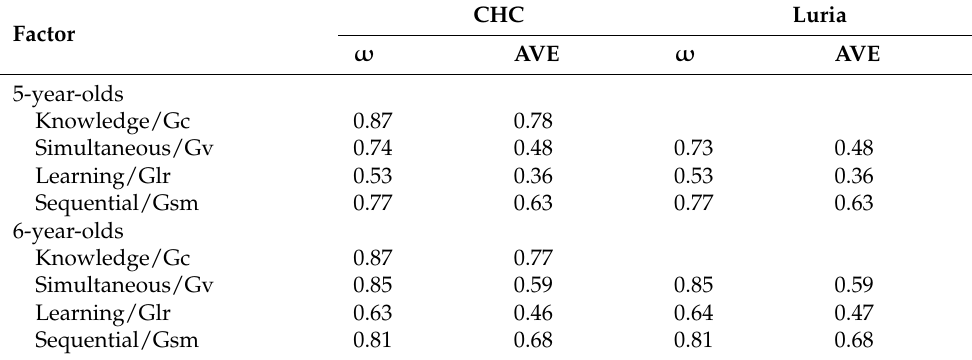
Table 8. Bifactor model of KABC-II core subtests: Factor loadings and sources of variance at age 5.